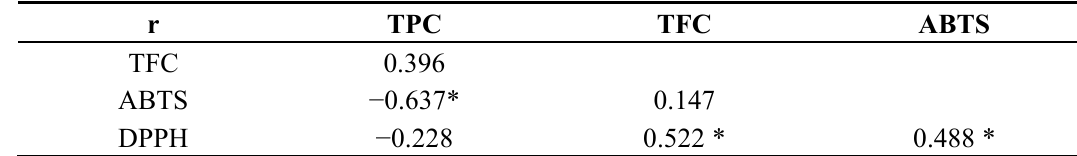
Table 3. Correlation between assays under influence of different experimental runs ( n =